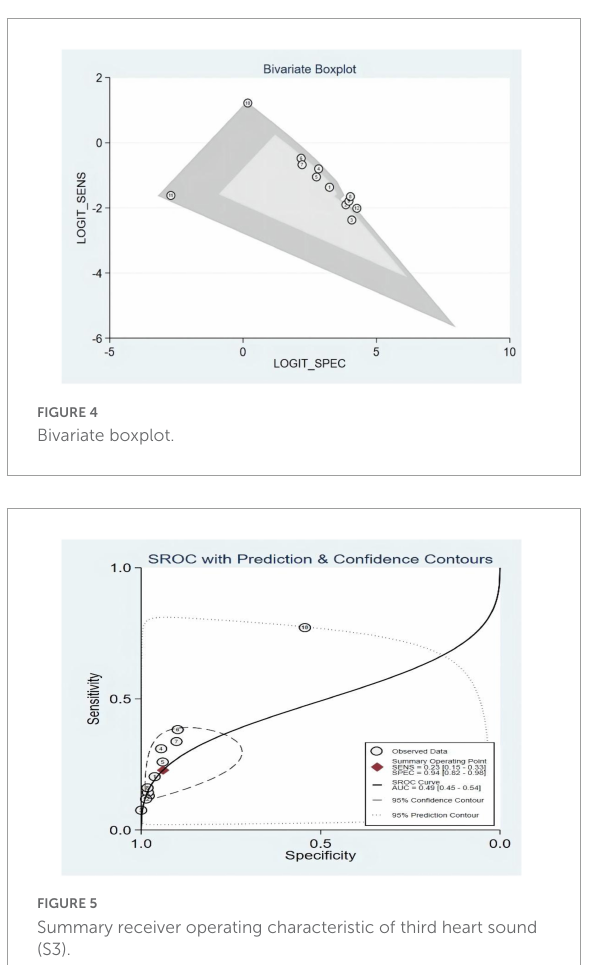
FIGURE4 Bivariate boxplot.